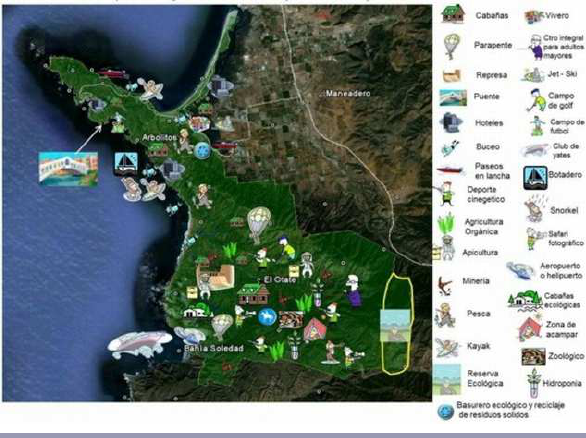
Fig. 13. Collective imagery by ejidatarios (taken from MEZA-UABC 2011.)